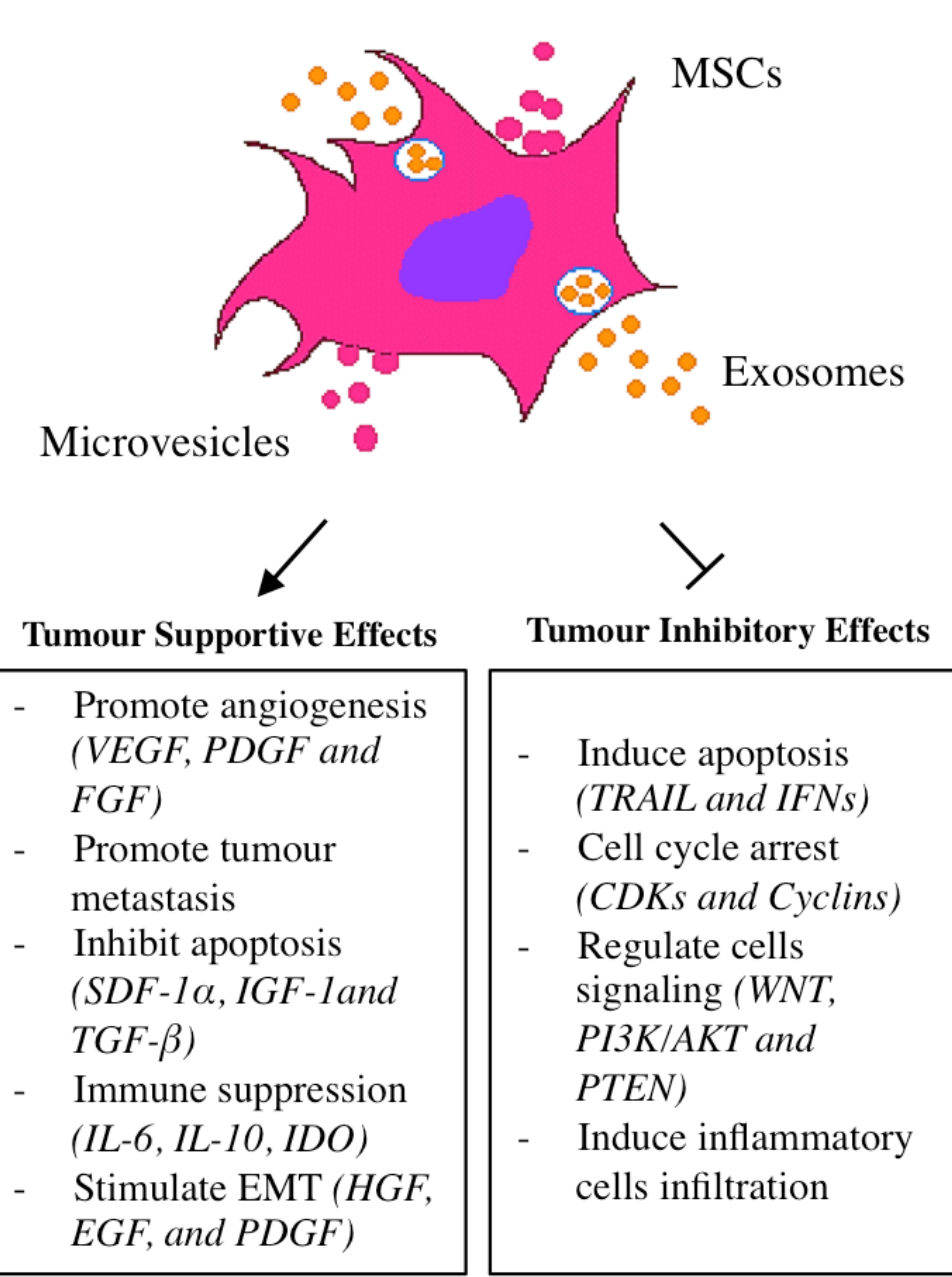
Figure 1. Engineered mesenchymal stem cells (MSCs) act to support and inhibit tumour growth. MSCs could induce apoptosis in some tumours, while others have reported that MSCs might also inhibit apoptosis. MSCs could promote vascularization in the tumour microenvironment by secreting growth factors and might also lead to tumour inhibition by inducing cyclin dependent kinases (CDKs) and cyclins block that leads to cell cycle arrest. These ambiguous roles of MSCs suggested that more studies are needed to elucidate the exact function of MSCs in different tumour models for a safer treatment outcome. TRAIL—tumour necrosis factor-related apoptosis inducing ligand; VEGF—vascular endothelial growth factor; PDGF—platelet-derived growth factor; FGF—fibroblast